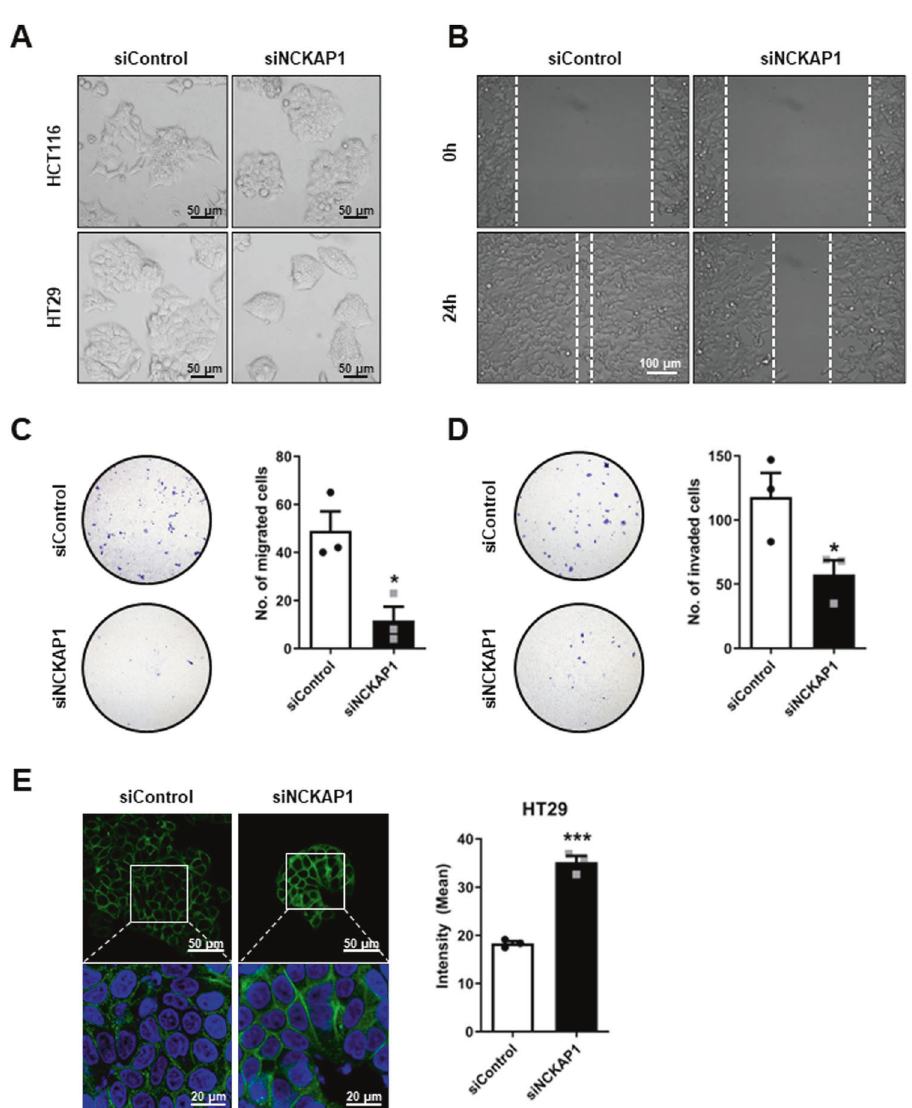
Fig. 2 Inhibition of metastasis characteristics by reduction of NCKAP1. A HCT116-Luc and HT29-Luc cells were transfected with 20 nM siControl or 20 nM siNCKAP1 for 72 h. Transfected cells were observed under a phase-contrast microscope. Bar, 50 μ m. B A wound healing assay was performed. HCT116-Luc cells were transfected with 20 nM siControl or 20 nM siNCKAP1 for 24 h and further seeded on Culture- Insert 2 Well for 24 h. After scratching, cell migration was monitored with a phase-contrast microscope for 24 h. Bar, 100 μ m. C, D A migration and invasion assay of HCT116-Luc cells transfected with 20 nM siControl or 20 nM siNCKAP1 for 72 h was performed. C The migrated cells were stained with crystal violet and observed using a fl uorescence microscope (10 X). Quantitative results on the right: Data are reported as the mean ± SEM. Student ’ s t-test. * p < 0.05 vs. siControl. ( n = 3). D The invaded cells were stained with crystal violet and counted. Quantitative results on the right: Data are reported as the mean ± SEM. Student ’ s t-test. * p < 0.05 vs. siControl. ( n = 3). E Transfected HT-29-Luc cells were subjected to immunocytochemistry of CDH1 and DAPI. Representative pictures of cells are shown by confocal microscope. Bar, 20 μ m and 50 μ m. Quantitative results on the right: Data are reported as the mean ± SEM. Student ’ s t-test. *** p < 0.001 vs. siControl. (n = for the analysis. In patients with CRC, the NCKAP1 levels were broadly expanded, and the high expression group had higher sensitivity of detection than normal samples (Fig. 5B). These results suggested that NCKAP1 might be applied as a novel marker for diagnosing the CRC stage and determining the prognosis of cancer progression.